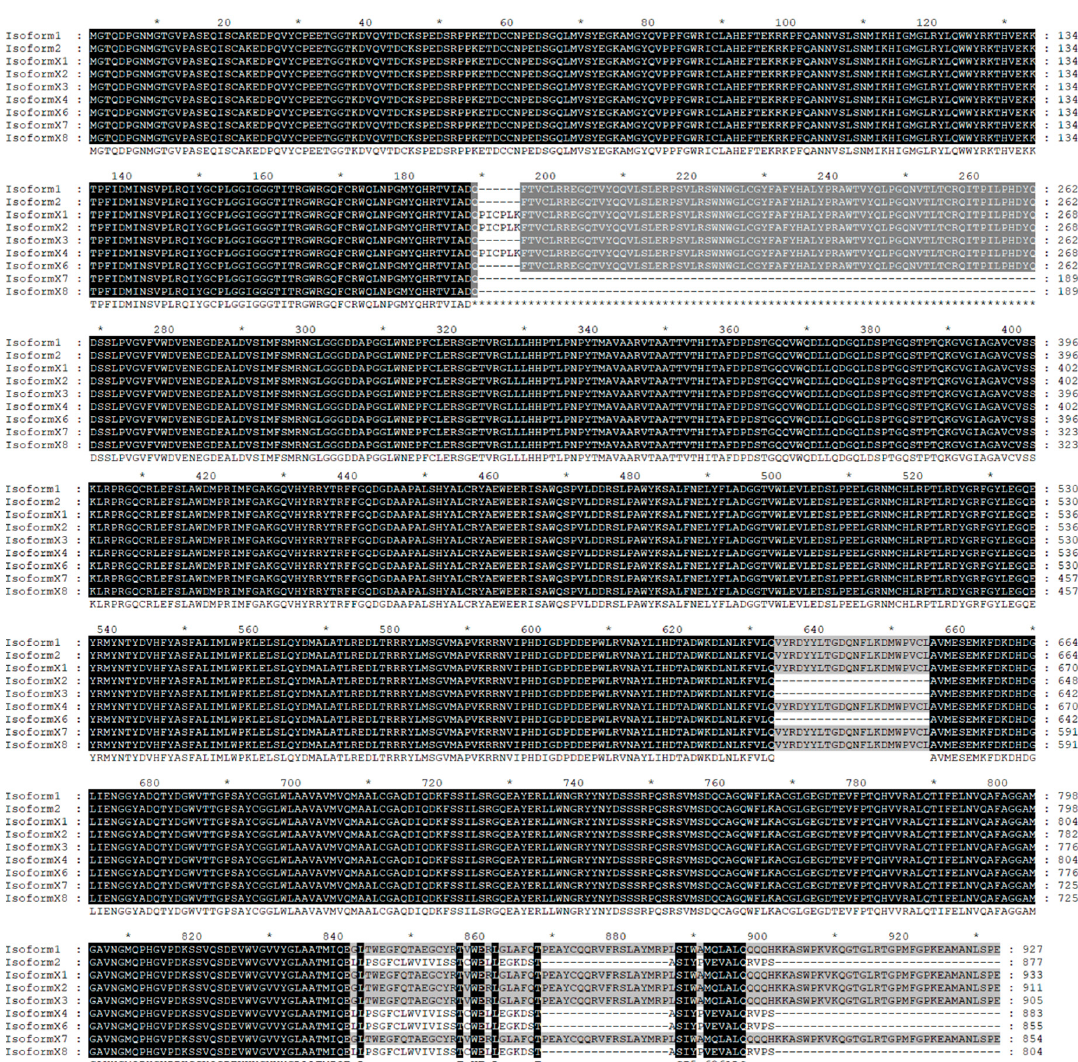
Figure 1. Protein sequence alignment of human GBA2 isoforms .